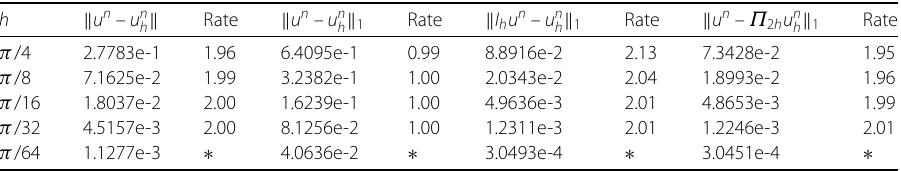
and α = 0.1 at 100